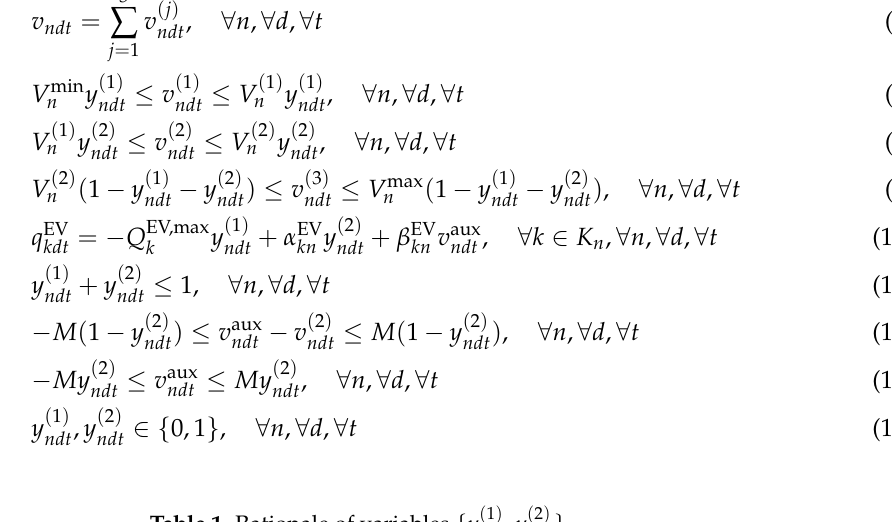
Table 1. Rationale of variables { y